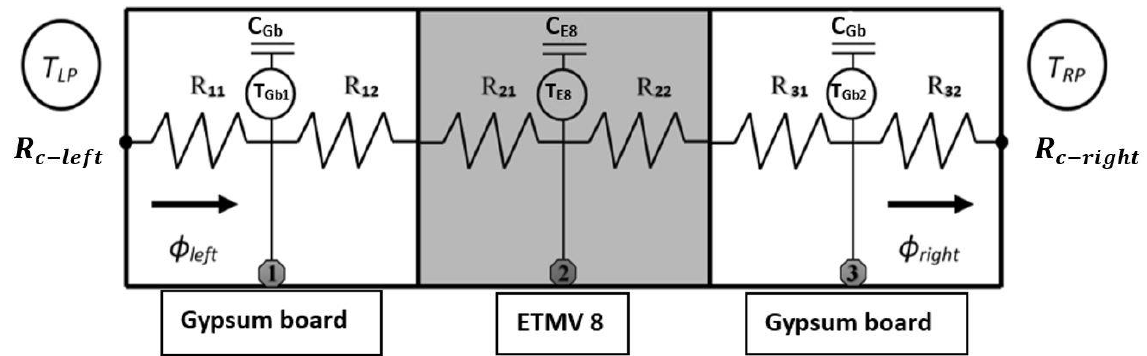
Figure 8. Simplified model of the gypsum board (Gb) and ETMV8 (E8) complex.